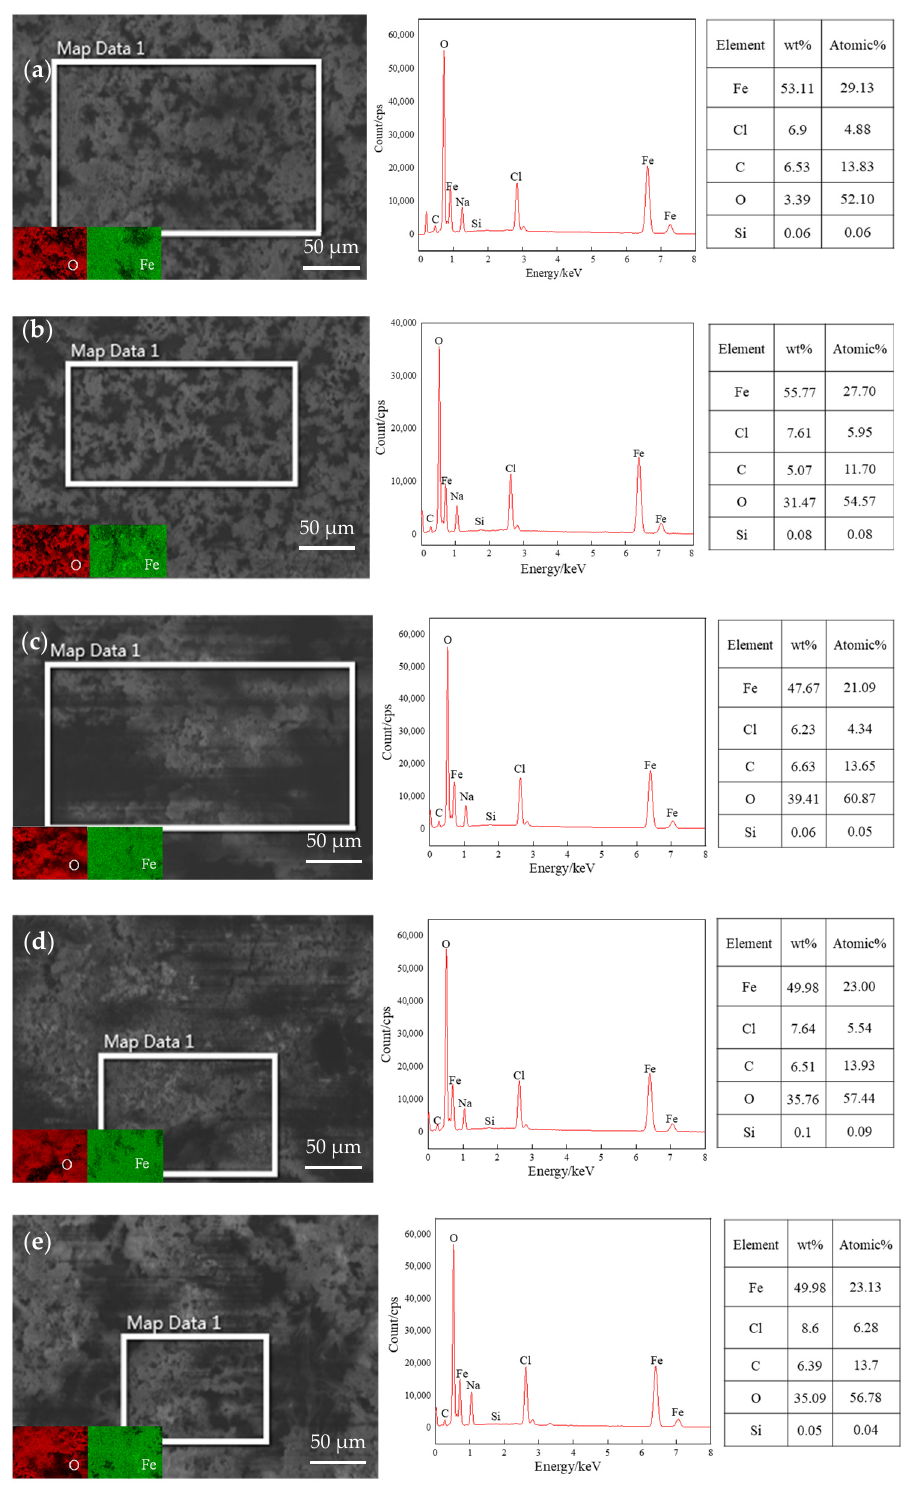
Figure 7. Energy dispersive spectroscopy images of the rust layer: ( a ) 48 h in 3.5% NaCl; ( b ) 144 h in 3.5% NaCl; ( c ) 288 h in 3.5% NaCl; ( d ) 144 h in 2.0% NaCl; and ( e ) 144 h in 5.0% NaCl.